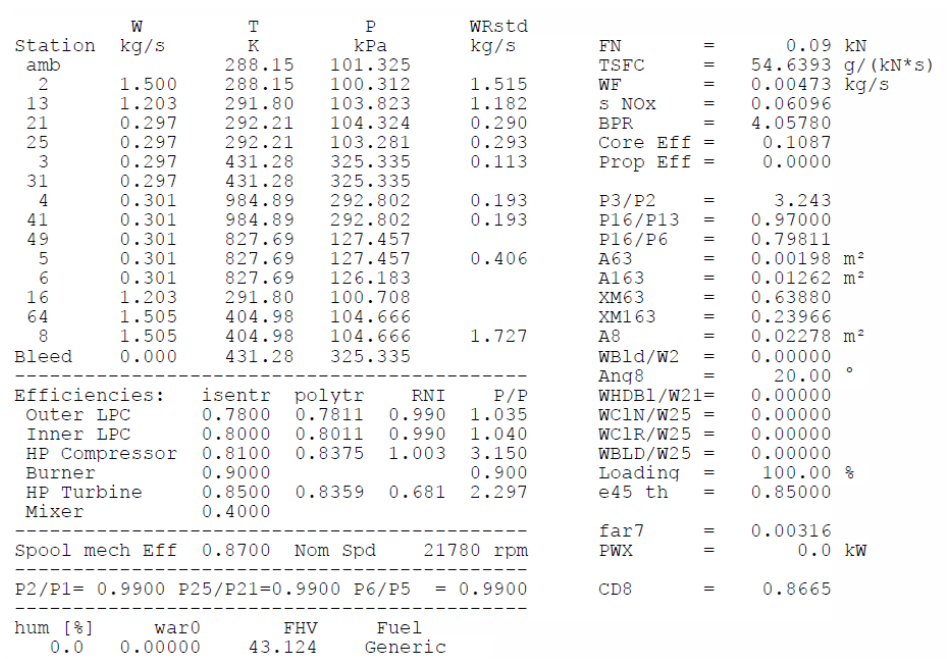
Figure A8. GasTurb Turbofan engine model input parameters—fan at 21,780 RPM.